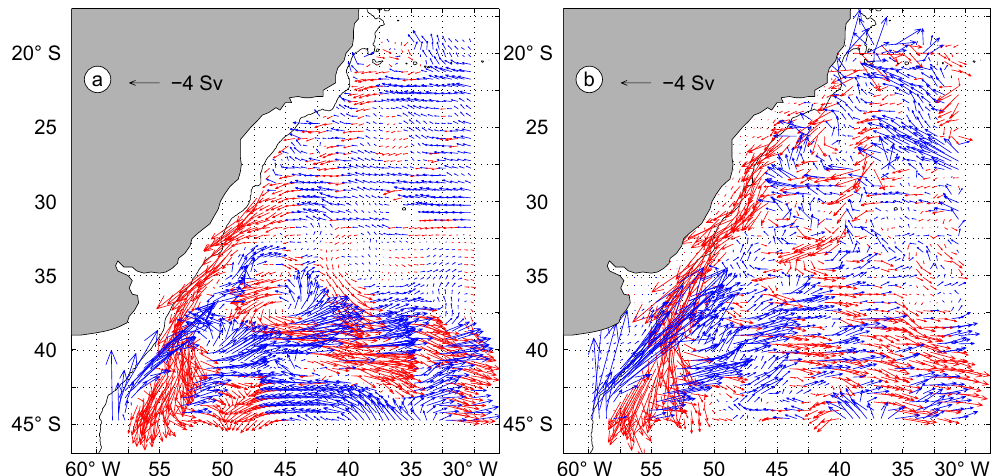
Figure 3. Climatological transport in the upper 800m of the southwestern South Atlantic based on Argo&SSH (a) and HYCOM (b) . Red (blue) vectors indicate southward (northward) meridional transports. The 800m bathymetry contour is also shown. It has to be noted that for HYCOM the resolution of 1 / 12 ◦ has been reduced to match the resolution of Argo&SSH (0.5 ◦ ) for the sake of visibility and comparability of the